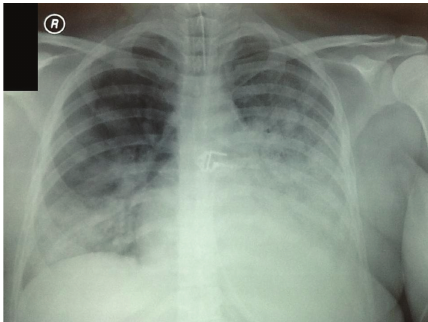
Figure 1: Chest radiograph of day 1 showing bilateral alveolar infiltrates and a dense area of consolidation with a small pleural reaction in the left hilar region.